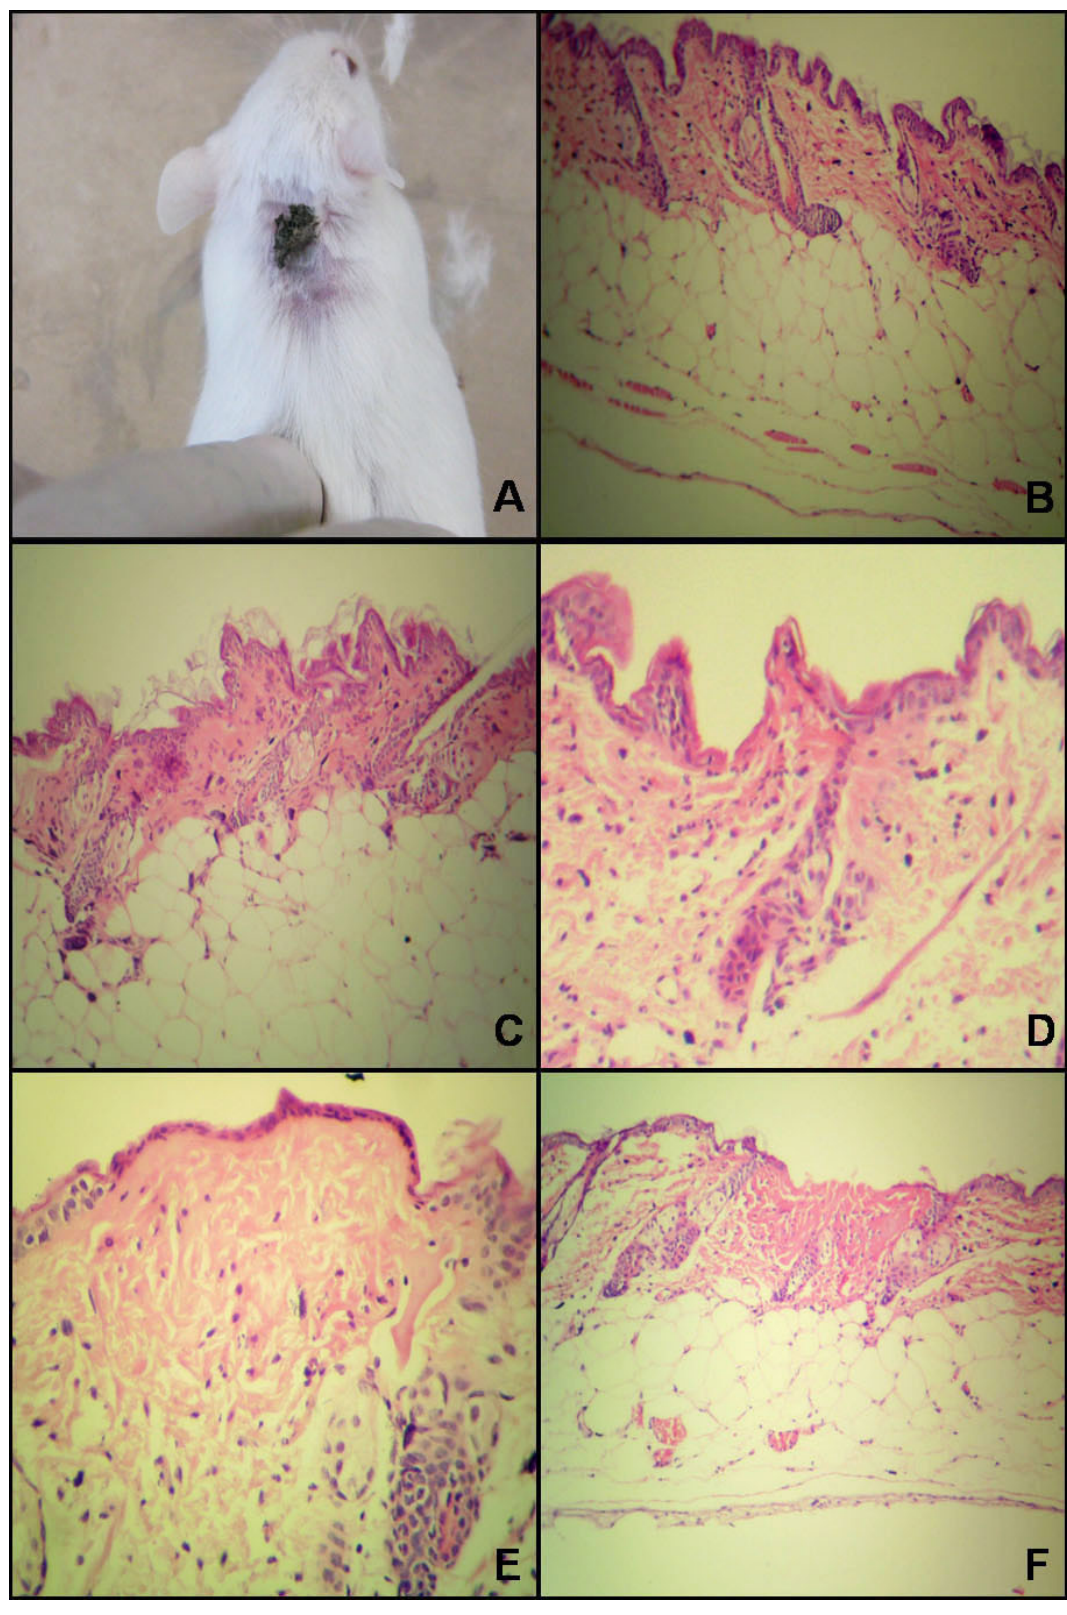
Figure 3. Histopathological lesions: (A) application site in mice, histological appearance of the animals after four hours; (B) negative control, the general architecture of the skin, particularly the epidermis, is preserved; (C) tape control, animals that received an application of: (D) intact sponges, (E) macerated sponges, and (F) isolated